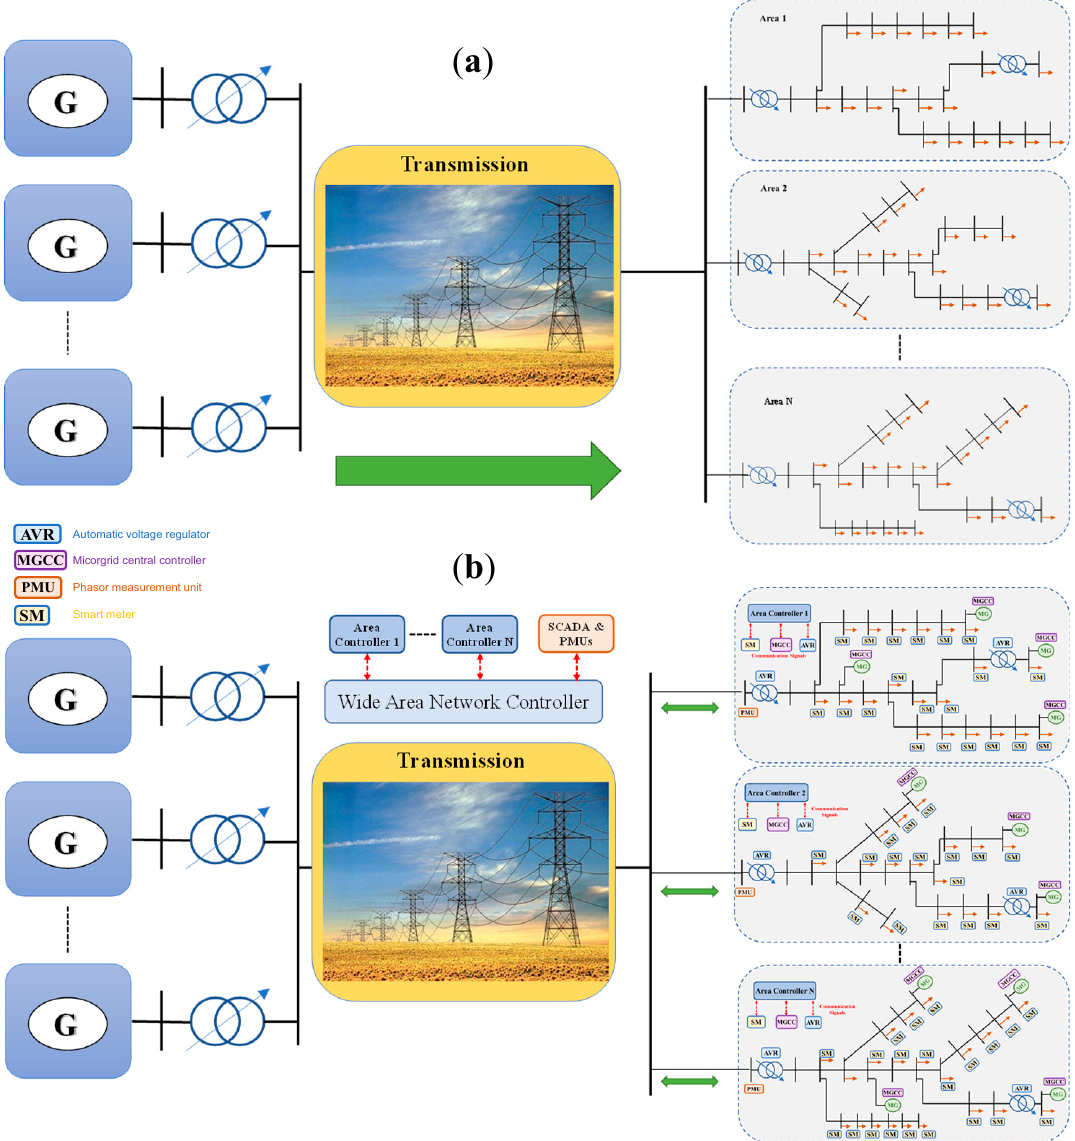
Figure 1. Electric power system: ( a ) the conventional version and ( b ) the smart grid version.